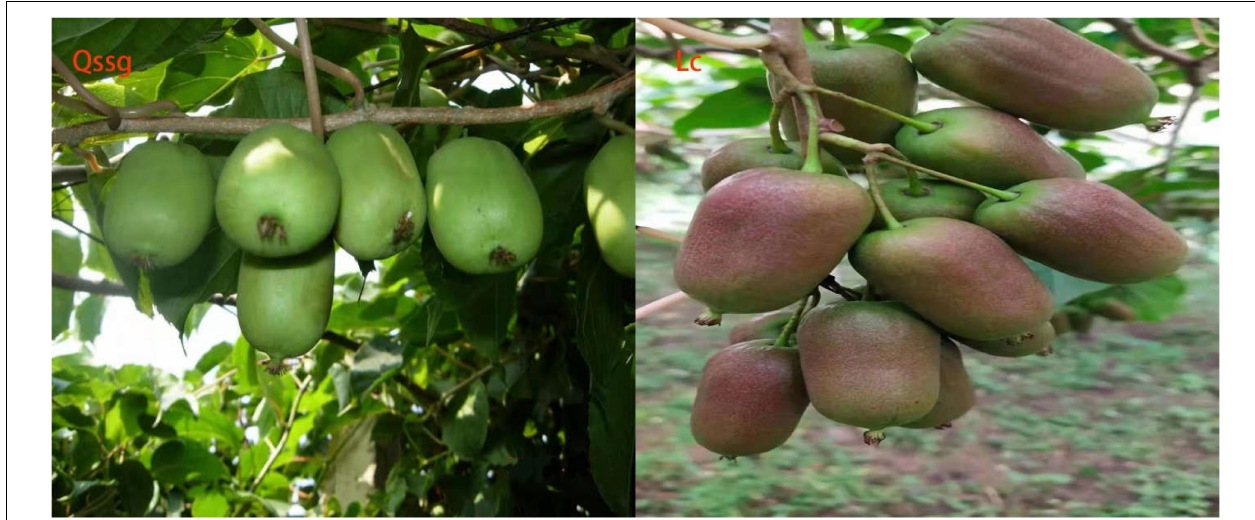
FIGURE 1 | Qssg and Lc of two main cultivars of Actinidia arguta Sieb.Zucc. in Northern China.